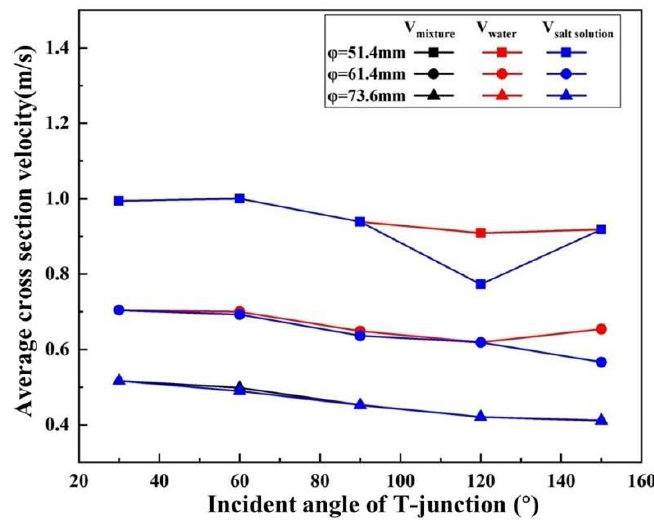
Figure 10. The average cross section velocities of mixture, water, and salt solution in the selected region.